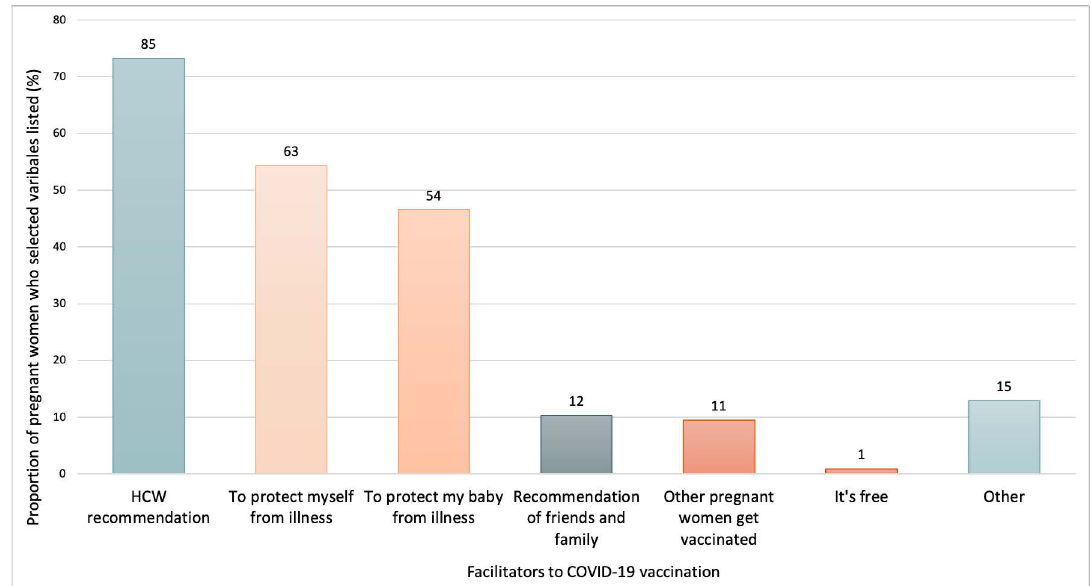
Figure 3. Facilitators for acceptance of COVID-19 vaccination reported by the pregnant women who received the maternal COVID-19 vaccination. N = 116. More than one answer possible. The figure shows data from participants enrolled during the period of the study after the effective implementation of national maternal COVID-19 recommendations, from 1 August 2021.